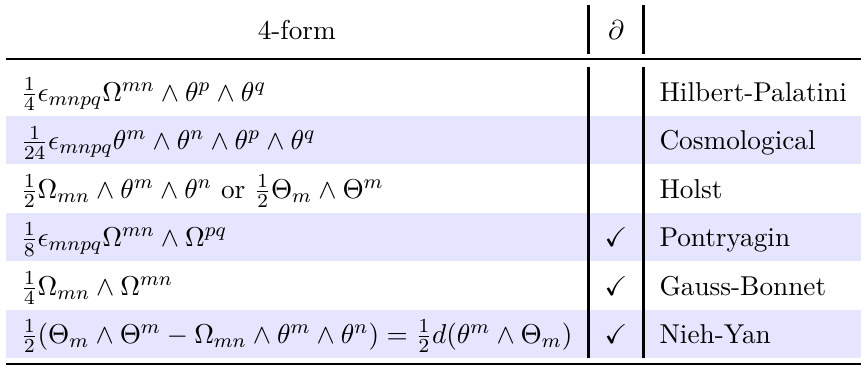
Table 7 . Summary of gauge-invariant 4 -forms and boundary terms ( ∂ ). The Nieh-Yan term shows that we could replace the Holst term by Θ m ∧ Θ m